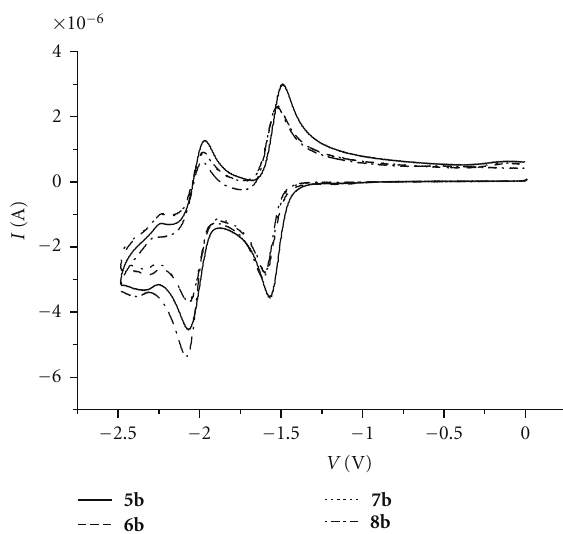
Figure 9: Cyclovoltammograms of monomers 5b – 8b with 1e − transfer (reduction cycles).